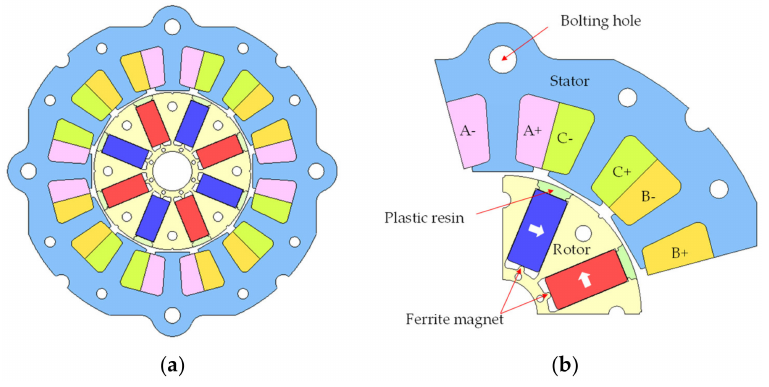
Figure 2. Structure of basic spoke type interior permanent magnet (IPM) model: ( a ) full model; ( b ) 1 / 4